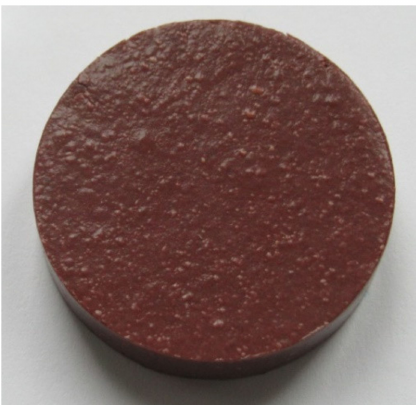
Figure 4. Sodium feldspar-quartz sample doped with 1.5% Fe 2 O 3 (I Na) after firing, whose surface is covered with numerous bubbles.